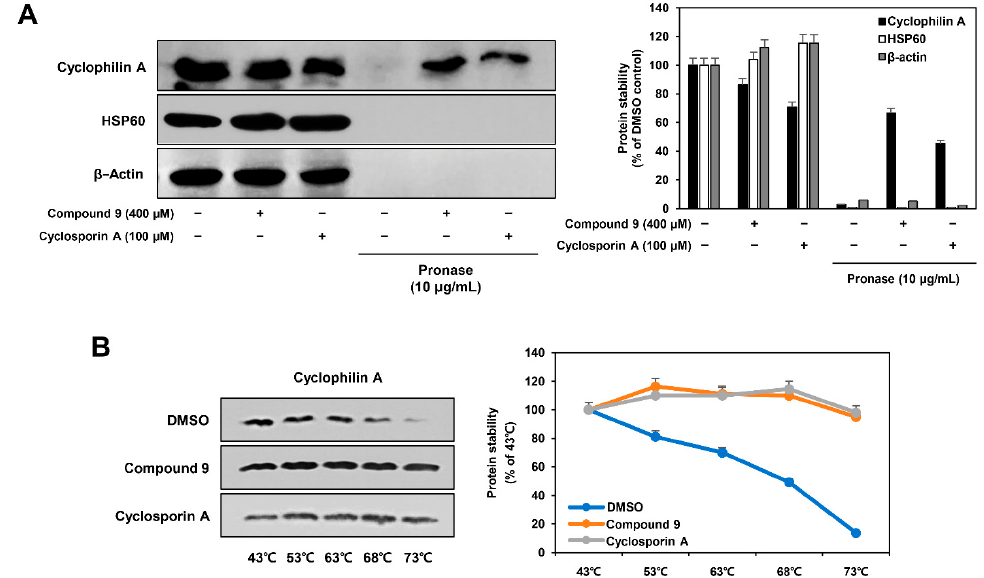
Figure 10. Identification of binding between compound 9 and CypA using ( A ) DARTS and ( B ) CETSA. ( A ) AGS cell lysates were incubated with DMSO, compound 9 (400 μ M), or cyclosporin A (100 µ M) for 1 h and then treated with pronase for 1 h. Protein levels were detected by western blot analysis and further quantified by densitometry. ( B ) AGS cell lysates were incubated with DMSO, compound 9 (400 µ M), or cyclosporin A (100 µ M) for 1 h and then heated at different temperatures (43–73 ◦ C) for 5 min. The supernatants of the heated samples were analyzed by western blotting and further quantified by